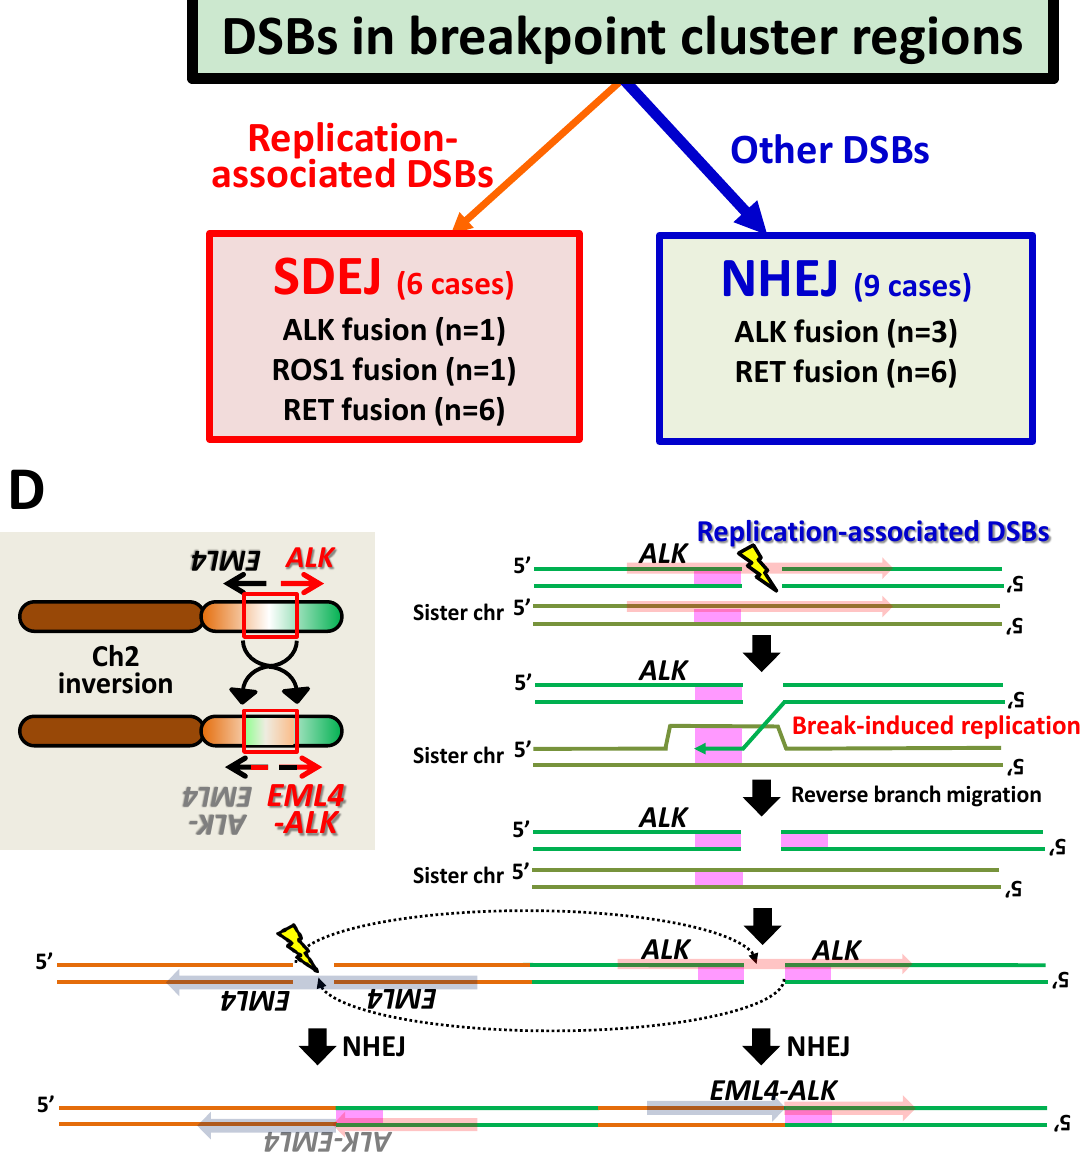
Figure 3. Deduction of joining repair pathways based on the structure of breakpoint junctions. ( A ) A representative case in which reciprocal fusion was determined to be caused by non-homologous end joining (NHEJ). Overlapping and deleted nucleotides at breakpoint junctions are indicated; ( B ) A representative case in which reciprocal fusion occurred with duplication of a genomic segment (indicated by black rectangle); ( C ) Molecular processes causing gene fusions in LADC. Illegitimate DSB repair by synthesis-dependent end-joining (SDEJ) and NHEJ produces oncogene fusion. The pathway used might depend on the type of DSB, i.e. , replication-associated or not; ( D ) Deduced process of reciprocal EML4-ALK fusion by SDEJ causing duplication of an ALK genome segment at breakpoint junctions, as in the case of AD09-055T (Figure